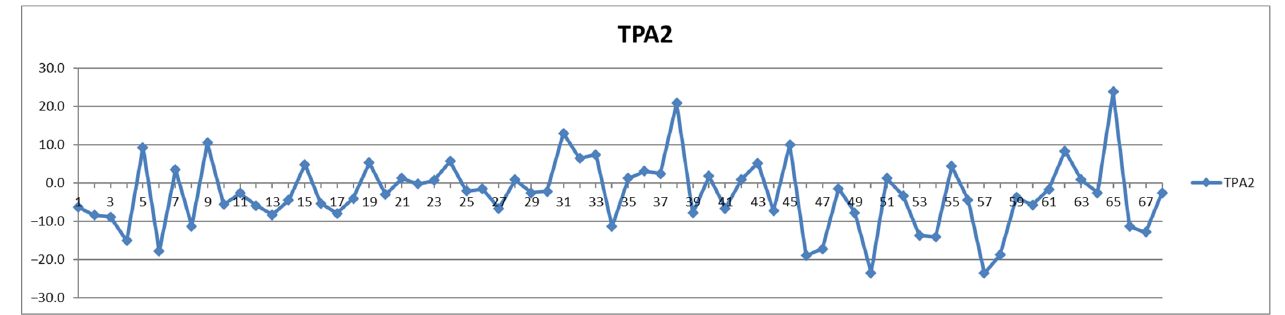
Figure 17. The food intake effect on total apolipoprotein A2 (TPA2) as difference between postprandial and fasting concentrations as percentage relative to fasting concentration.